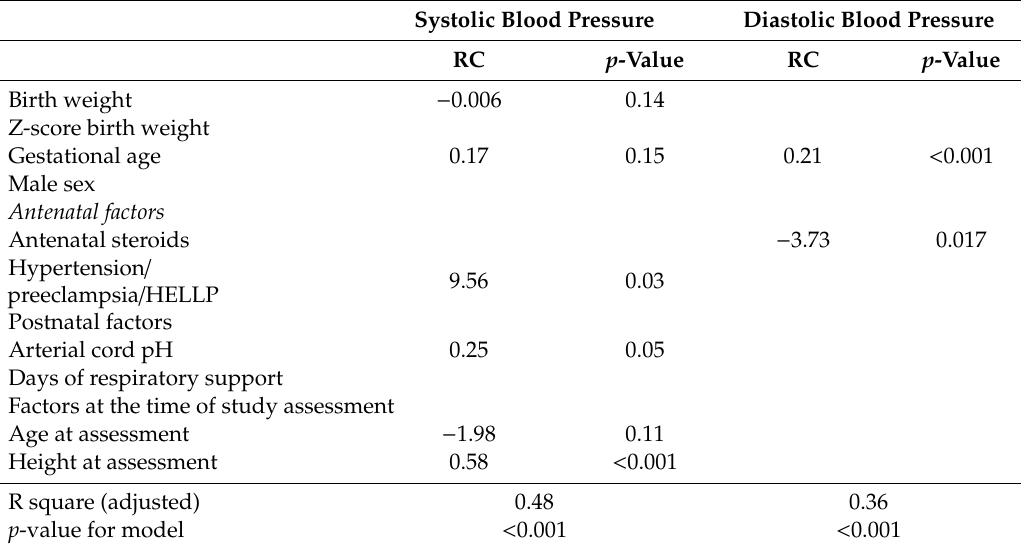
Table 4. Regression model for systolic and diastolic blood pressure in relation to pre-, peri-, and postnatal factors for preterm-born study